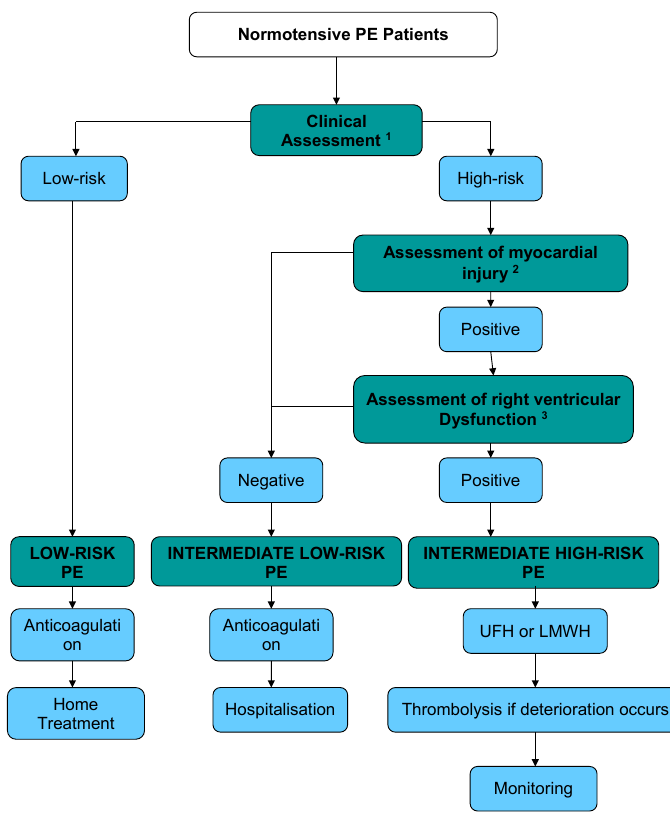
Figure 2: Stepwise algorithm for managing a normotensive patient with PE 3 1= using sPESI, 2= measure cardiac troponins, 3= use echocardiography * patients with concomitant